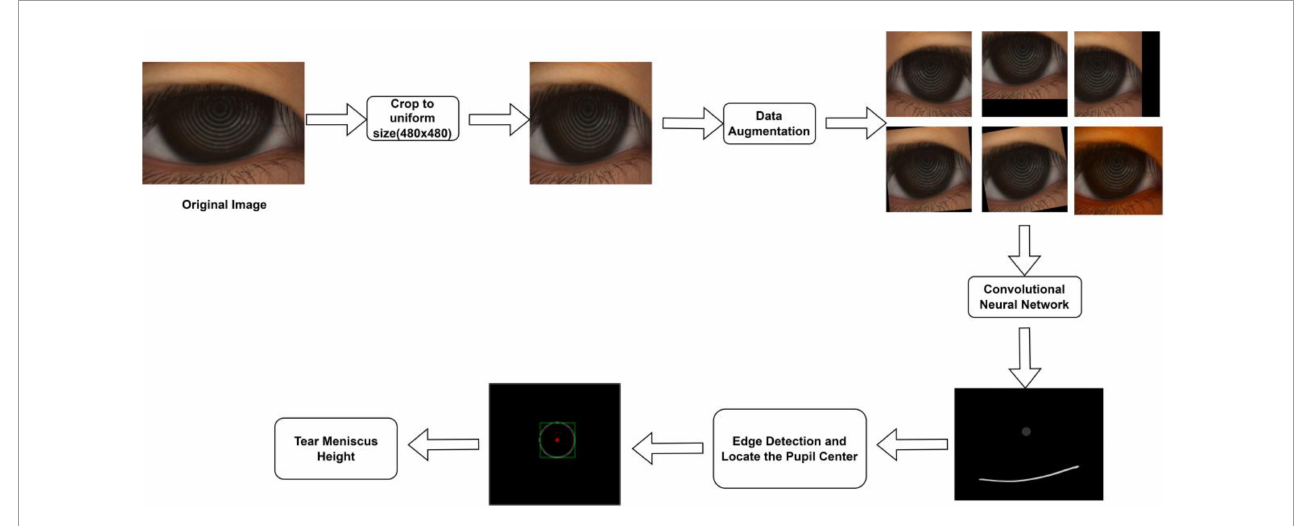
FIGURE2 Automatic measurement process of